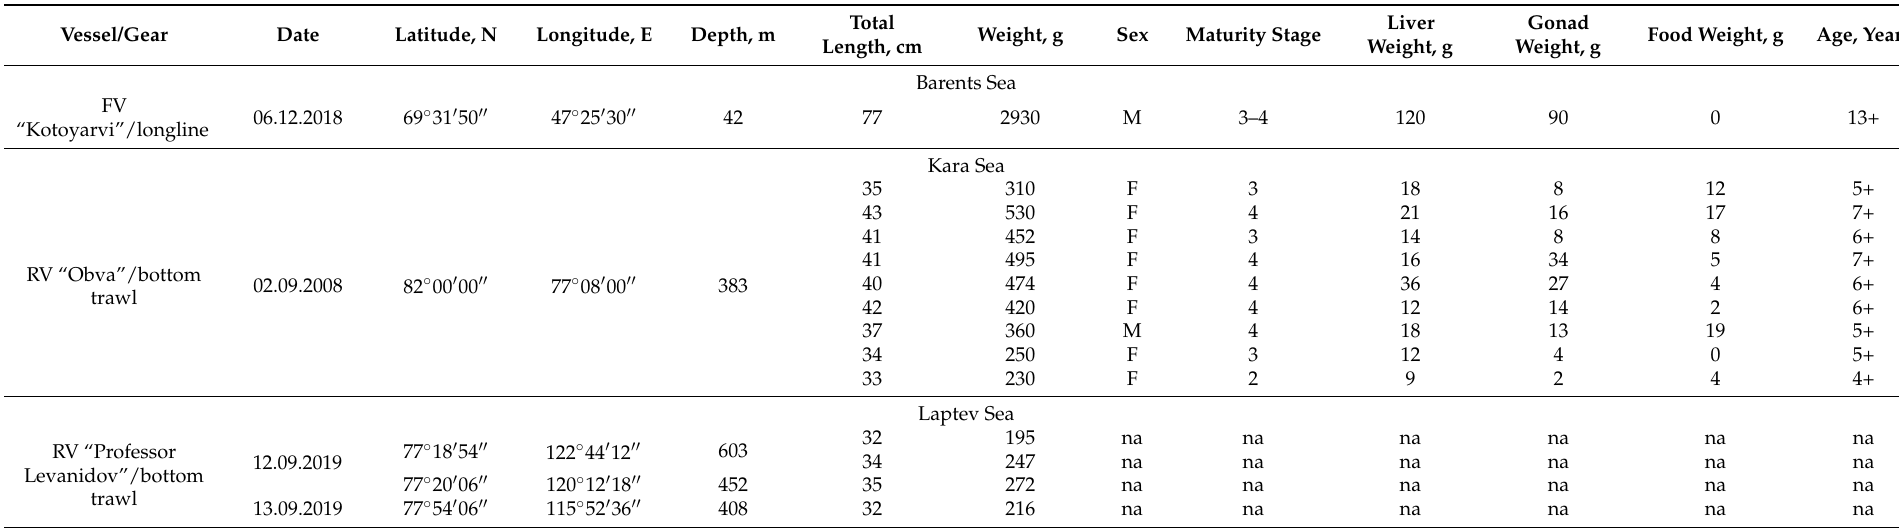
Table 1. Data on new captures of walleye pollock Gadus chalcogrammus in the Siberian Arctic (M = male, F = female, na = not available).